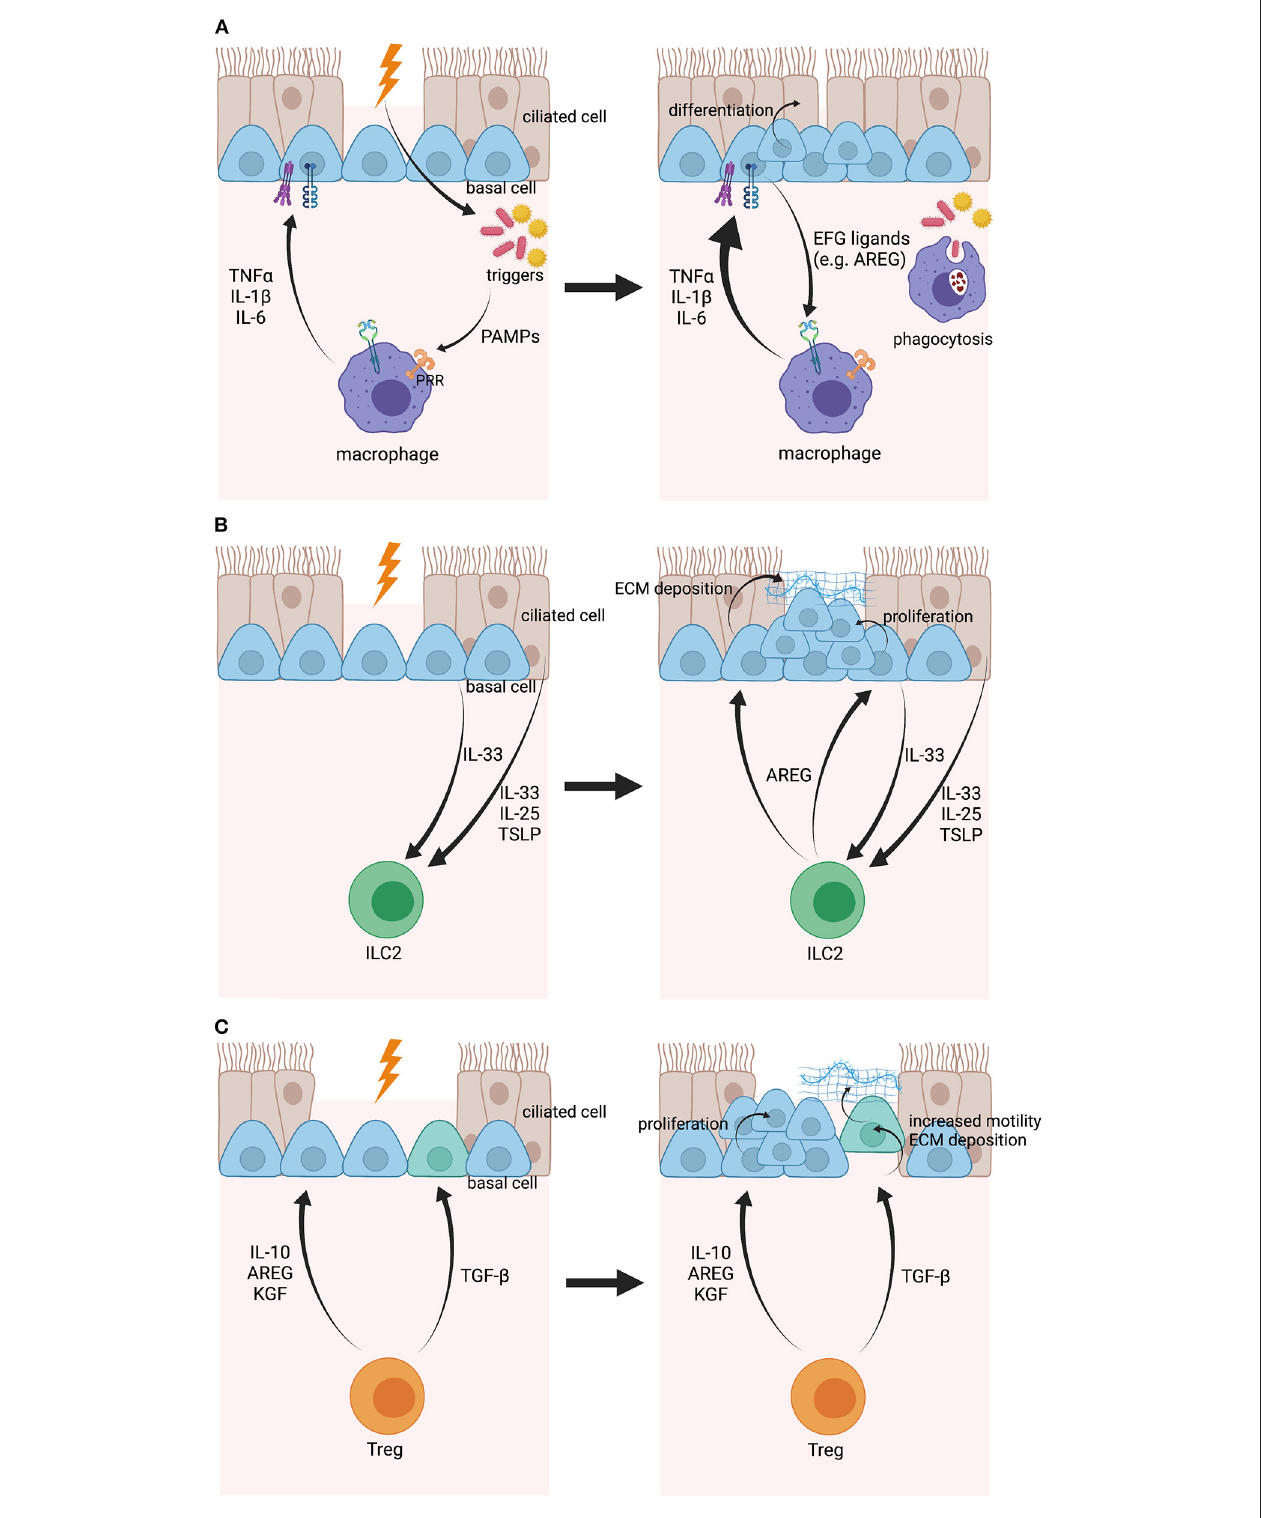
FIGURE 2 | Illustration of the crosstalk between airway basal cells and macrophages, ILC2s and Tregs, respectively, upon epithelial damage. (A) When the epithelial barrier is damaged, pathogens, or other environmental triggers can enter the subepithelial space and will be sensed by macrophages via PRRs. Macrophages